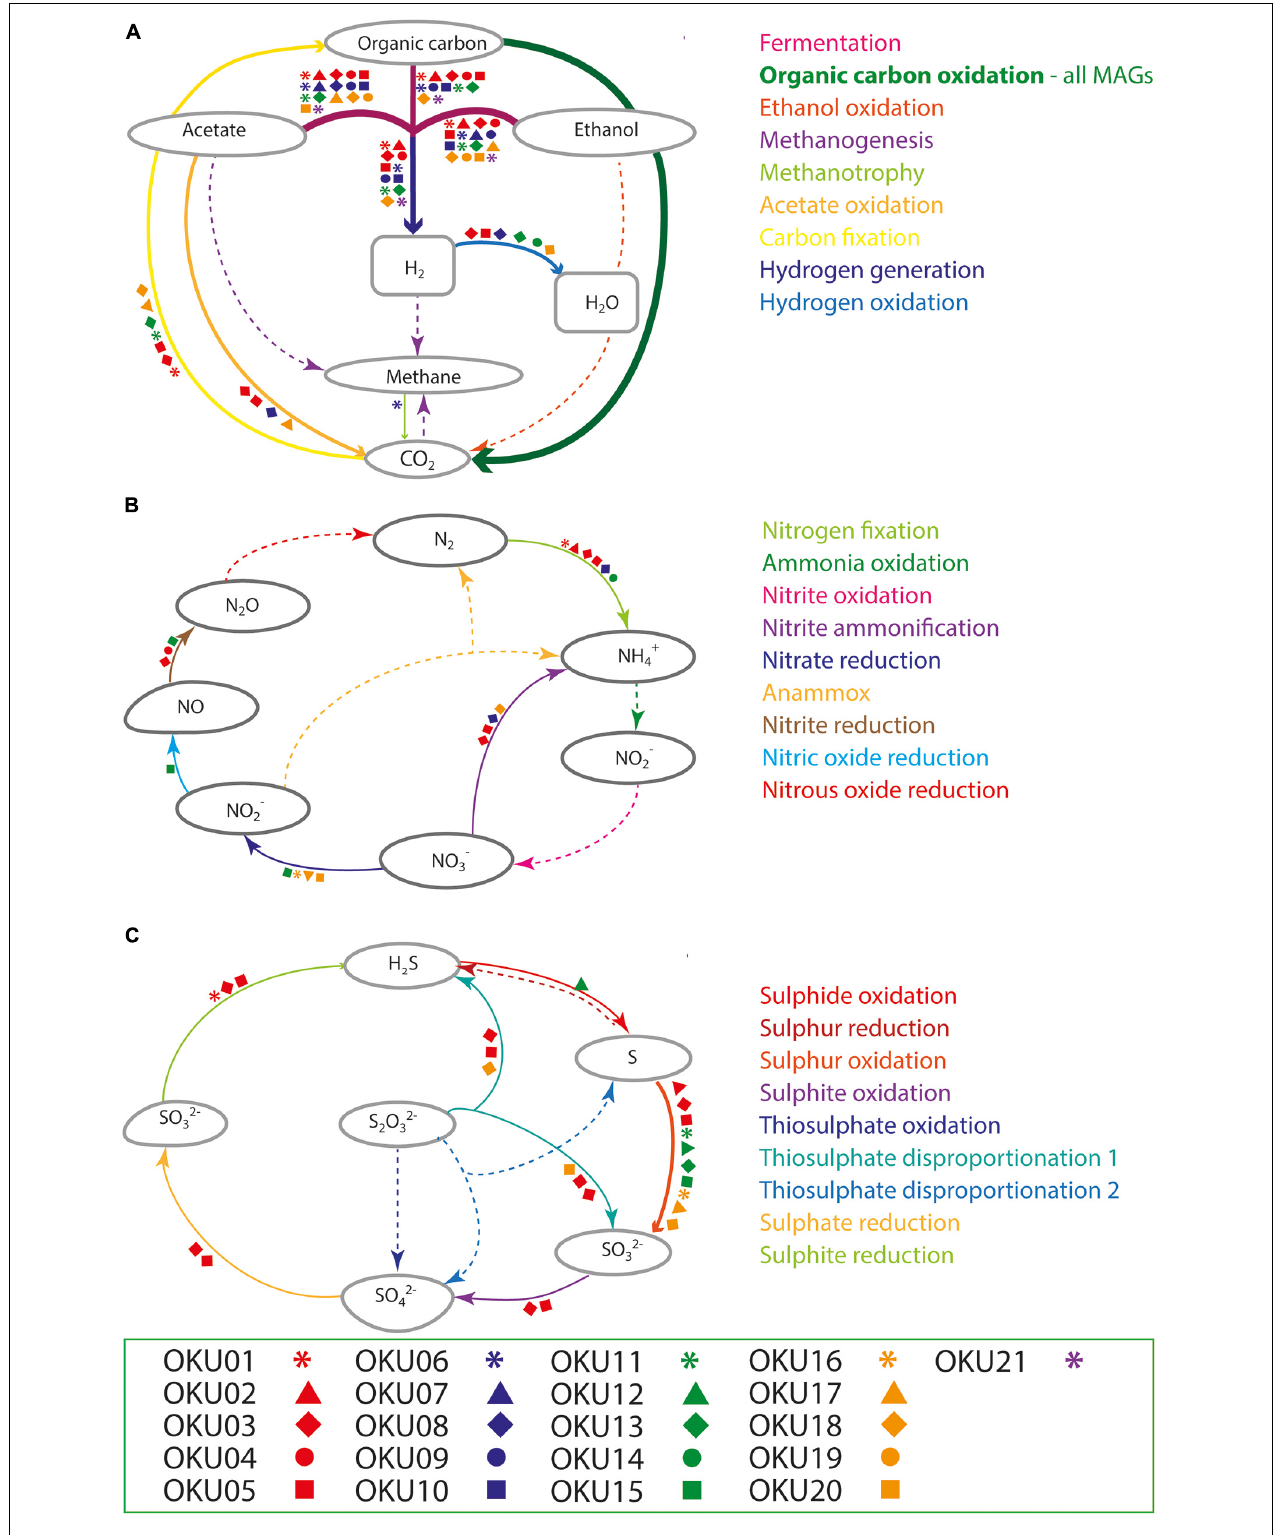
FIGURE 8 | Compilation of carbon (A) , nitrogen (B) , and sulfur (C) cycling pathways across mica schist MAGs according to METABOLIC analysis. Detected pathways are marked with arrows, whereas missing pathways are marked with dashed arrows. Different MAGs linked to the detected pathways are marked with the symbols according to the